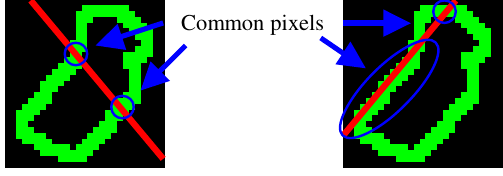
Figure 7: Example of 1 st longenst matched line search Next, 2 nd longest matched line is searched. In 1 st longest matched line search, this method makes a line from the combination of all two points on the bounding rectangle of edge image. However, from 2 nd longest matched line search, it makes a line from the point on every N th longest line to all points on the bounding rectangle of edge image shown in Figure 8.